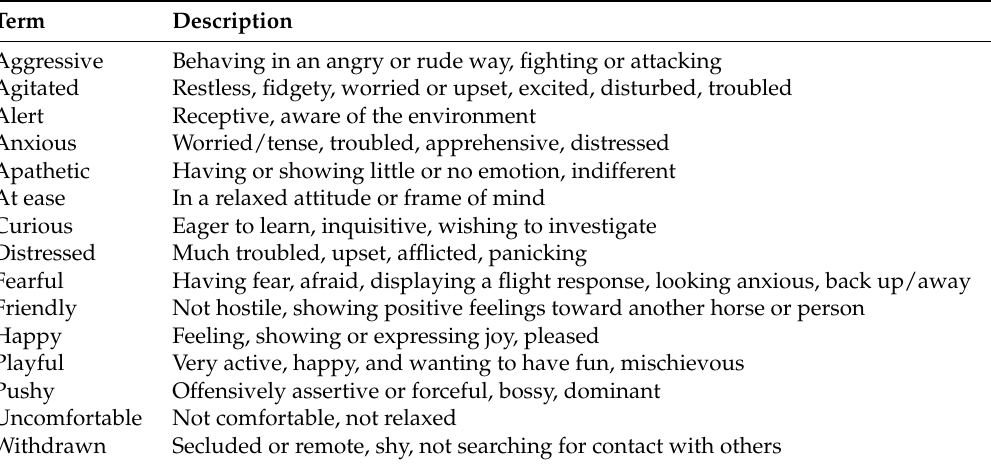
Table 2. The pre-selected terms and descriptions used in a study to assess students’ interpretation of expressive horse behaviour, based on Minero et al.